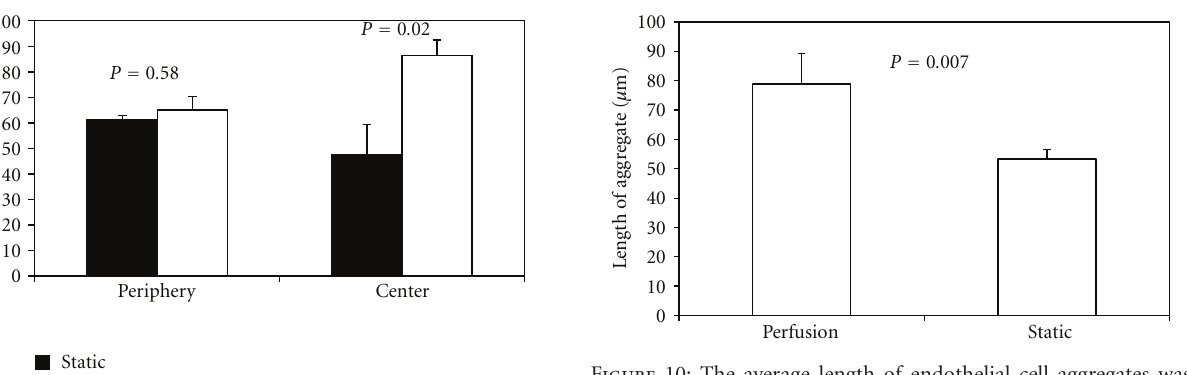
Figure 10: The average length of endothelial cell aggregates was increased in cell-seeded three-dimensional sca ff olds and exposed to perfusion flow ( n = 72 aggregates) compared to static conditions ( n = 114 aggregates).